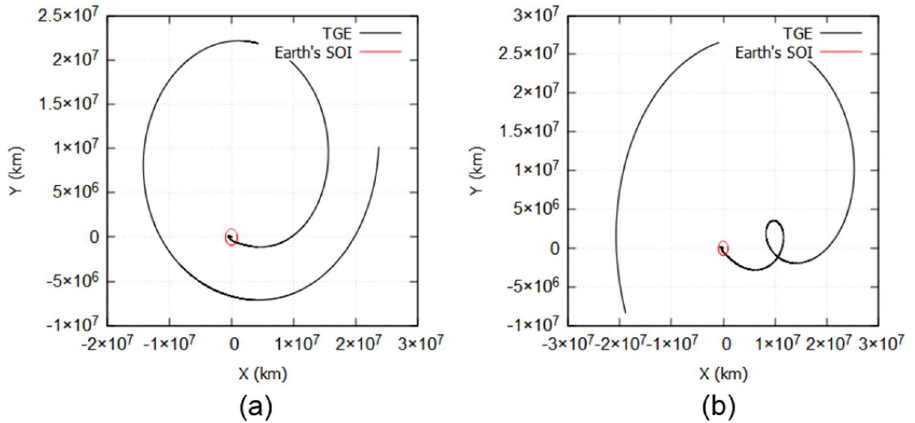
Figure 7. Examples of TGEs considered in the study, in the geocentric reference frame. ( a ) A direct and more feasible TGE to accomplish the transfer. ( b ) A more complex and not suitable